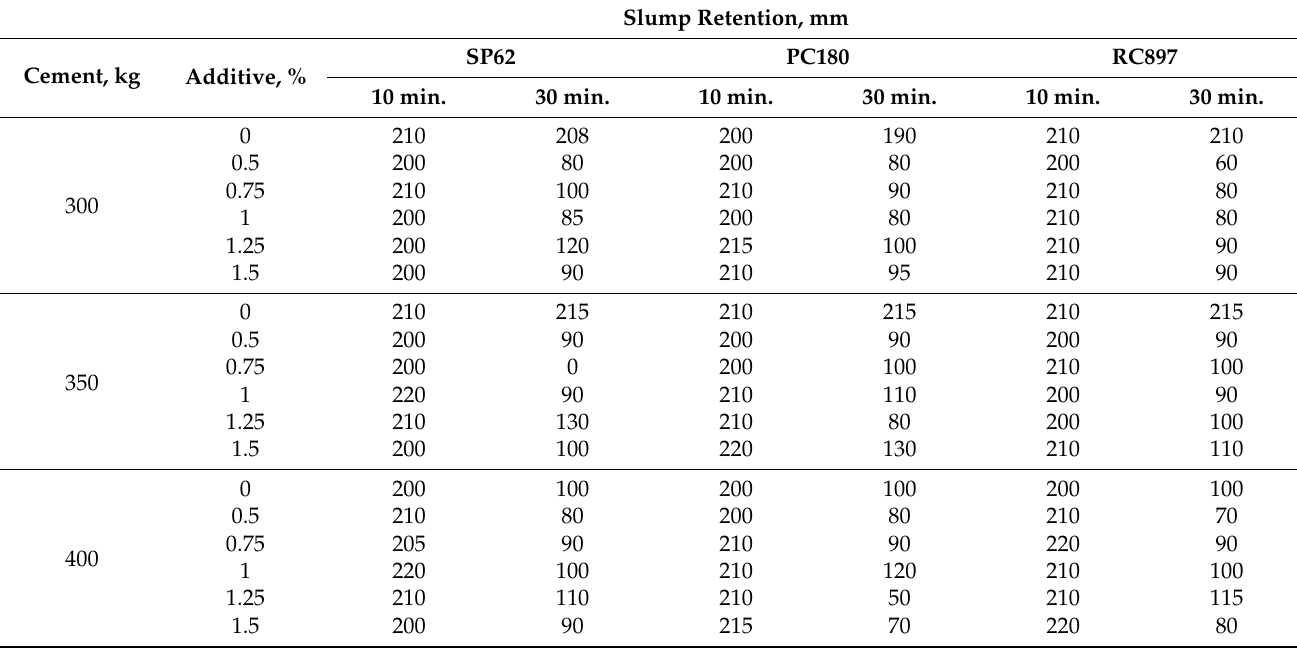
Table 4. Impact of the additives on the workability of